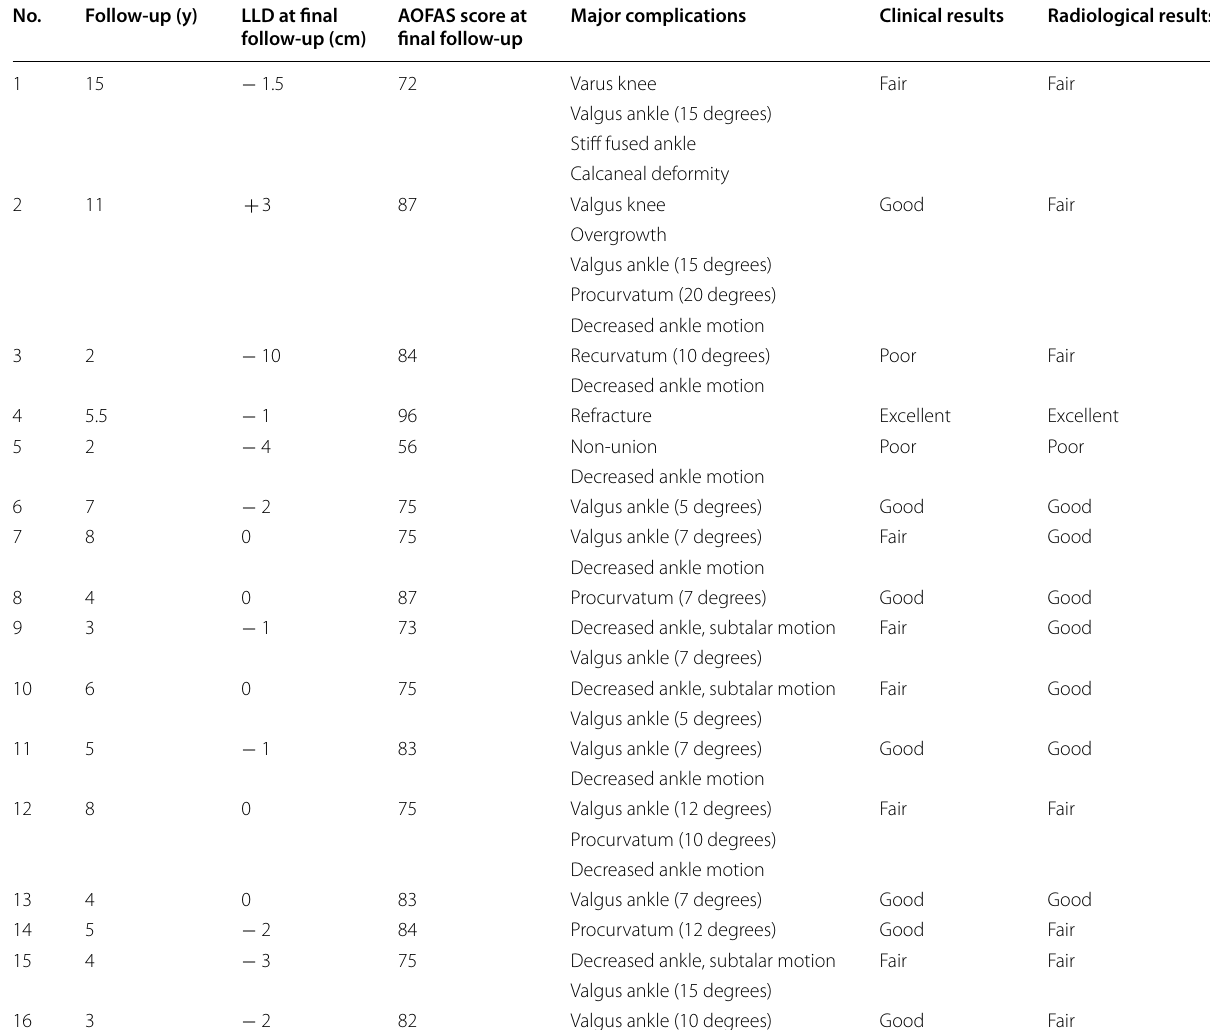
Table 6 Final results and complications of surgery